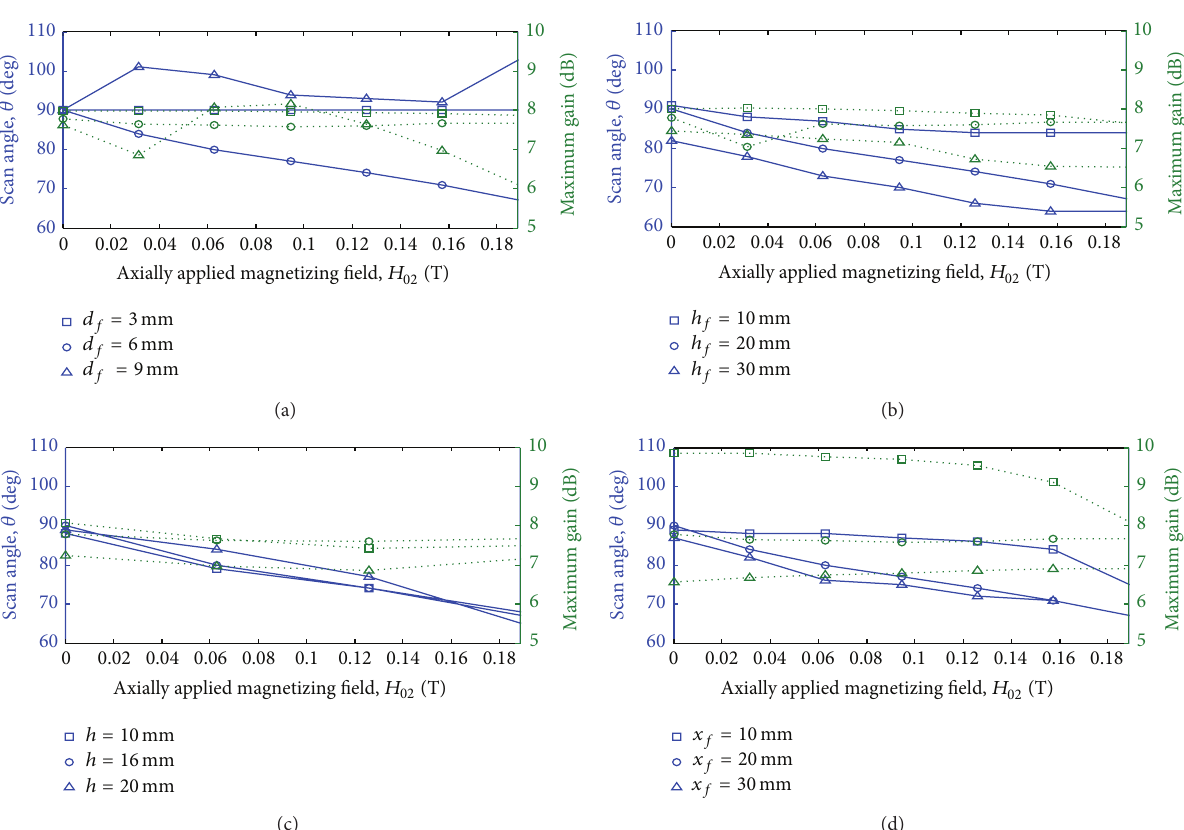
fed patch to resonate at 10 GHz. The optimized dimensions of = 1.6 mm, 𝑊 = 40 mm, 𝐿 = 40 mm, the MPA are ℎ sub ferr ferr = 8.5 mm, and 𝐿 = 8.72 mm. The ferrite rods are 𝑊 𝑝 𝑝